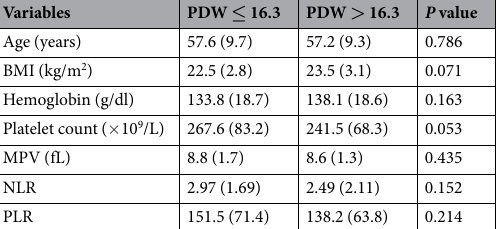
Table 2. Baseline characteristics of the patients with lung cancer according to PDW levels. PDW, platelet distribution width; BMI, body mass index; MPV, mean platelet volume; NLR, neutrophil-to-lymphocyte ratio; PLR, platelet-to-lymphocyte ratio.